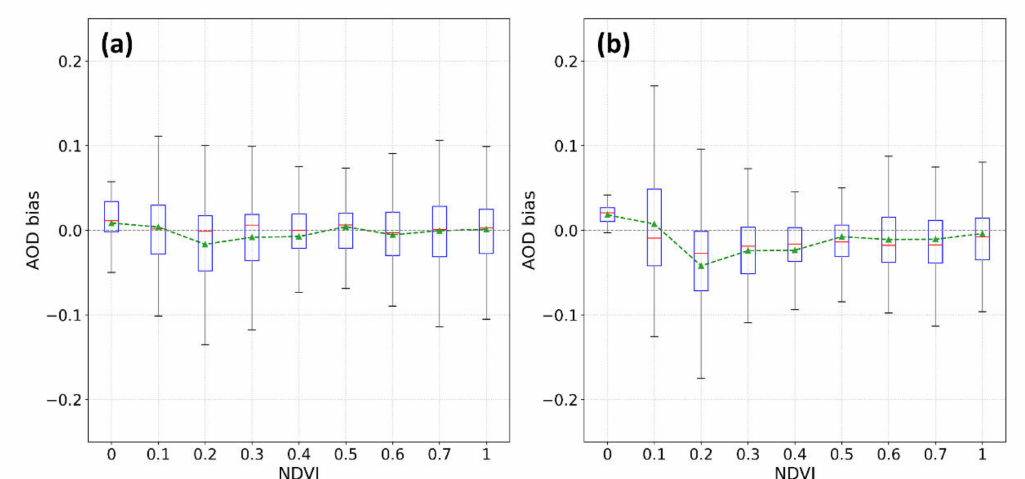
Figure 4. Box plots of AOD bias (in grey) for ERF-estimated AOD ( a ) and MODIS AODs ( b ), against AERONET AODs, as a function of NDVI. In each box, the green triangle and the middle, lower, and upper horizontal lines represent the AOD bias mean, median, and 25th and 75th percentiles, respectively.